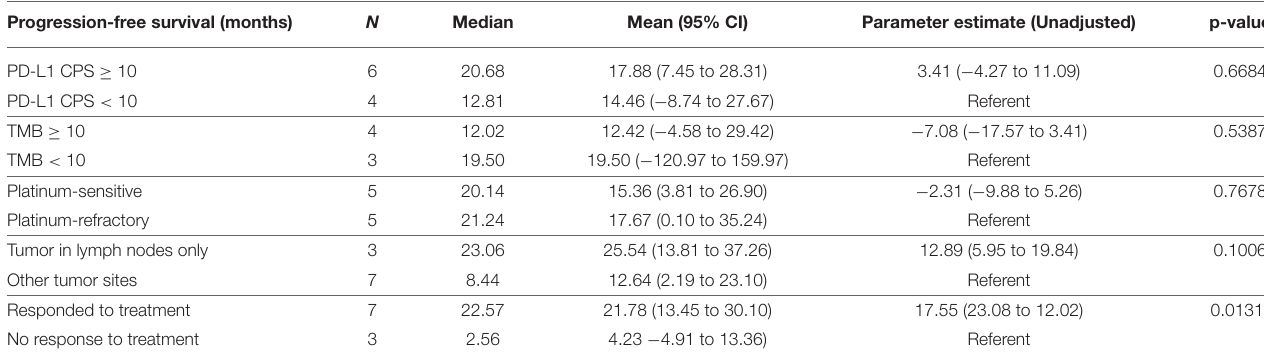
TABLE 3 | Correlation of progression-free survival with